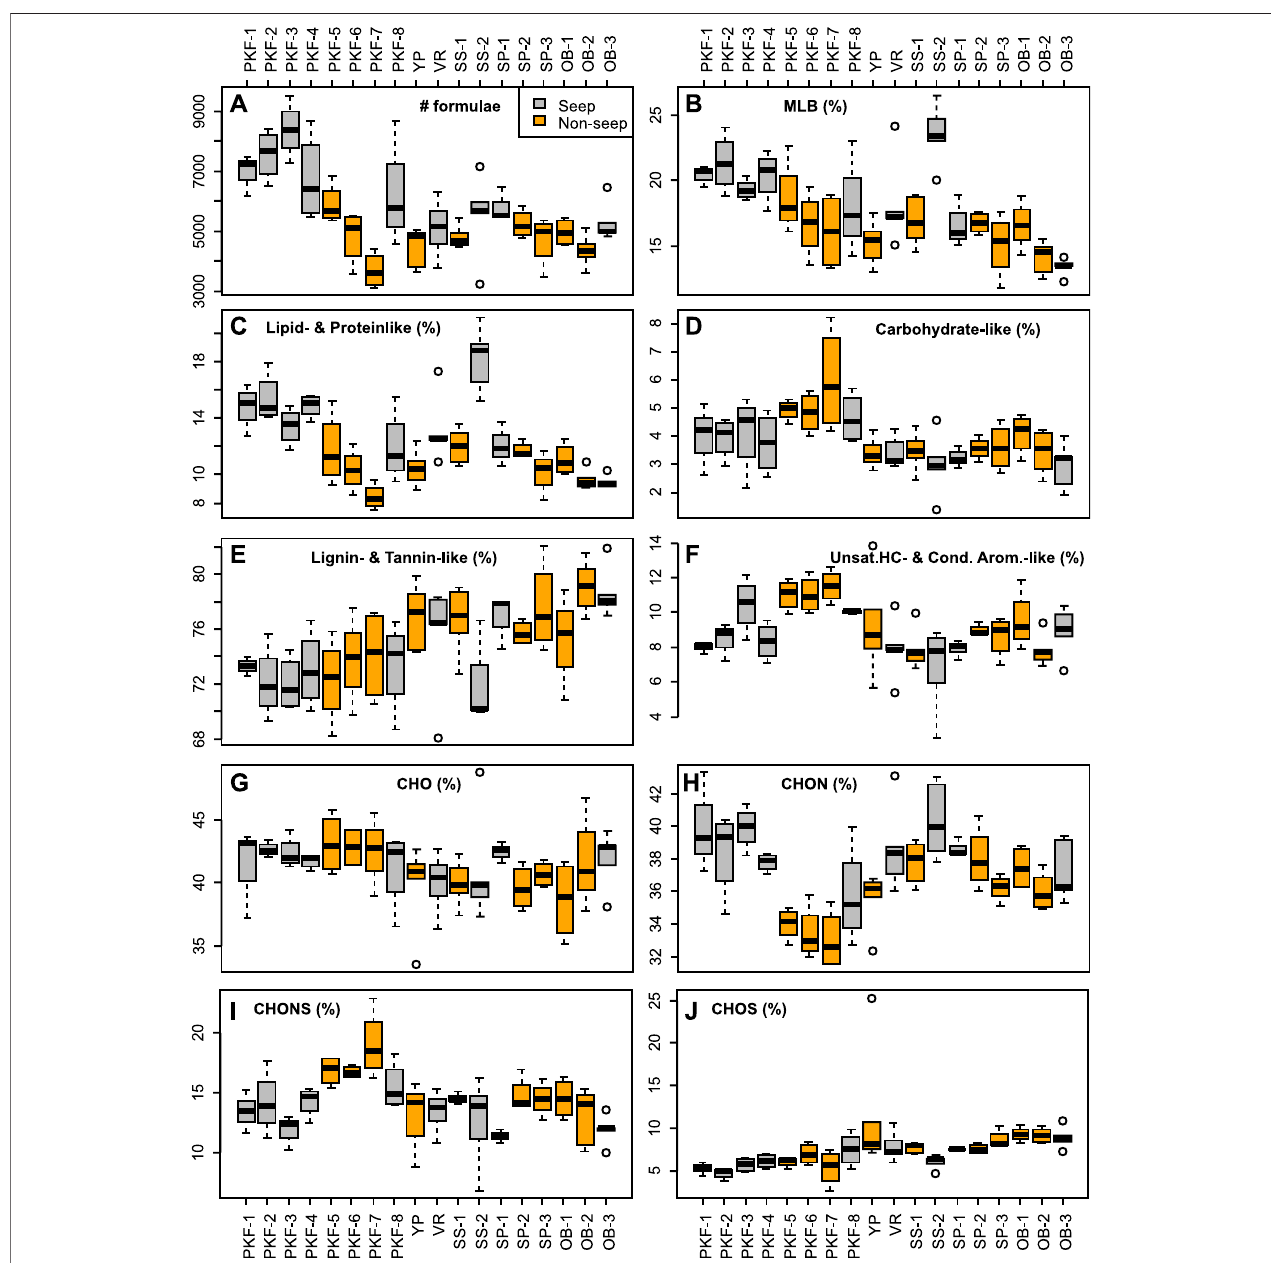
FIGURE 7 | Dissolved organic matter composition data determined by ESI FT-ICR MS organized by sampling stations shown as boxplots for (A) number of molecular formulas, (B) percentages of chemical lability (MLB L; ; D ’ Andrilli et al., 2015) (C – F) chemical groups based on modi fi ed regions of characterization classes on van Krevelen diagrams ( Figure 2 ), and (G – J) and heteroatomic content. Seep and non-seep stations are colored by grey and orange, respectively. Stations are abbreviated as given in Table 1 .